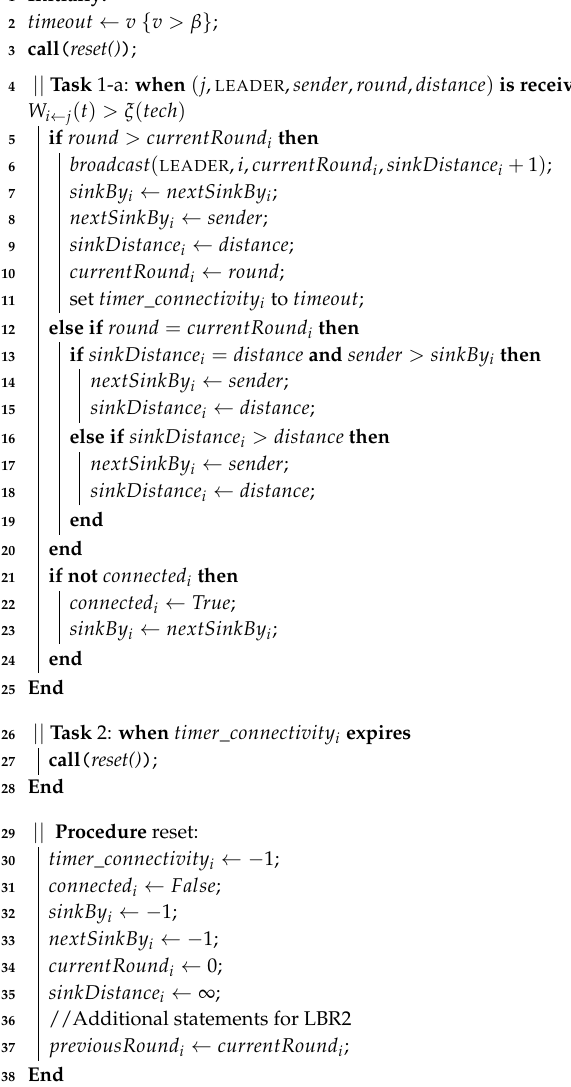
Algorithm 1: The algorithm LBR1 executed by any sensing node p i . Lines 26–38 are also shared with LBR2.